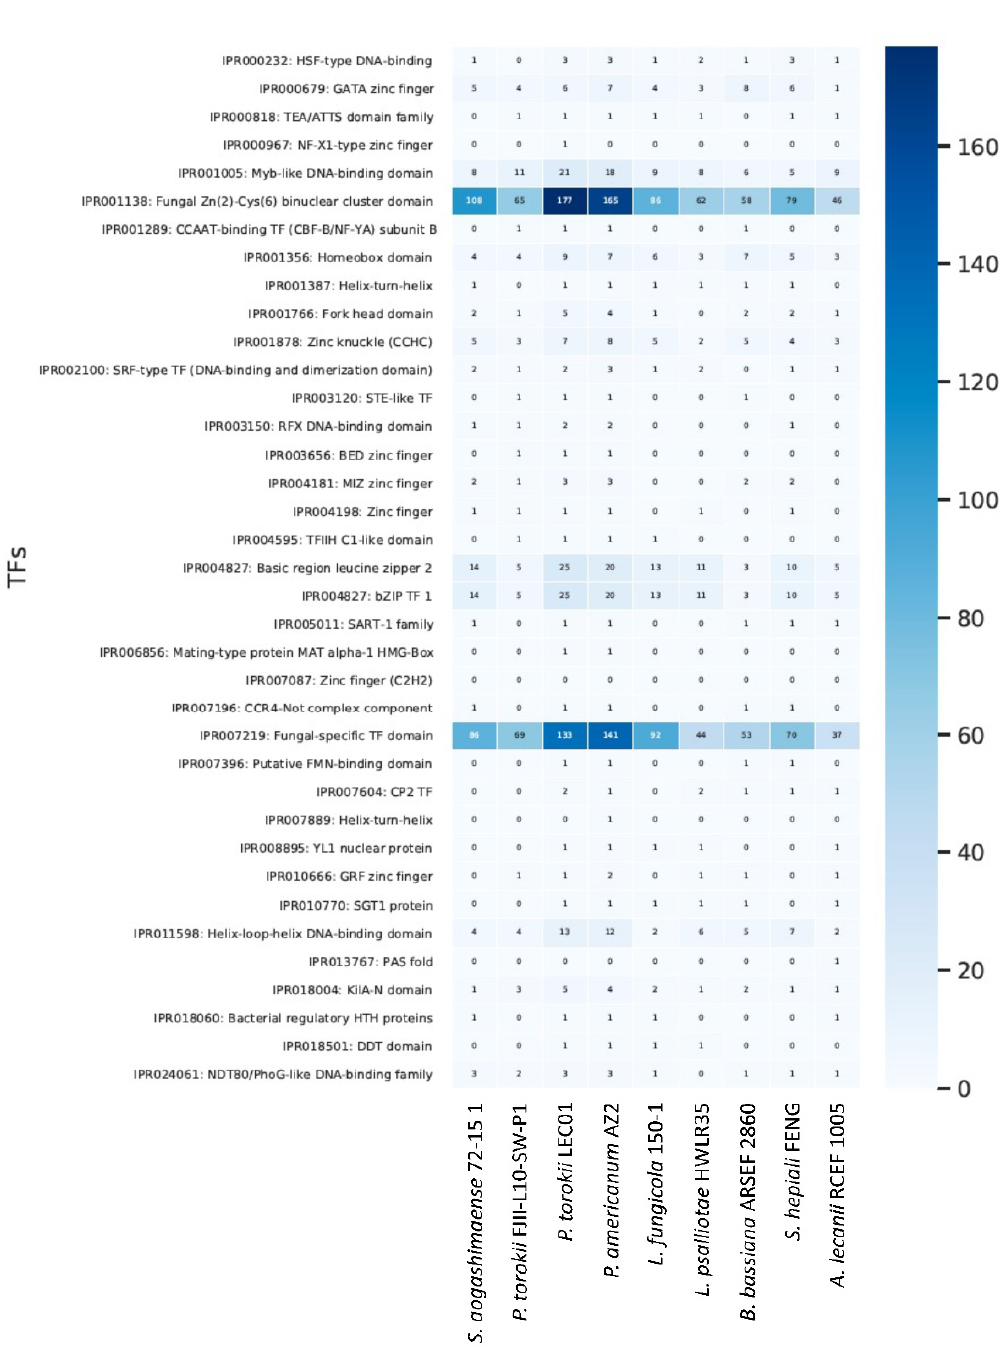
Figure 6. Fungal-specific transcriptional factors among the Cordycipitaceae species. Fungal tran- scription factors were screened in 9 Cordycipitaceae genomes and compared. Factors with a standard deviation >1 was plotted in a heat map.